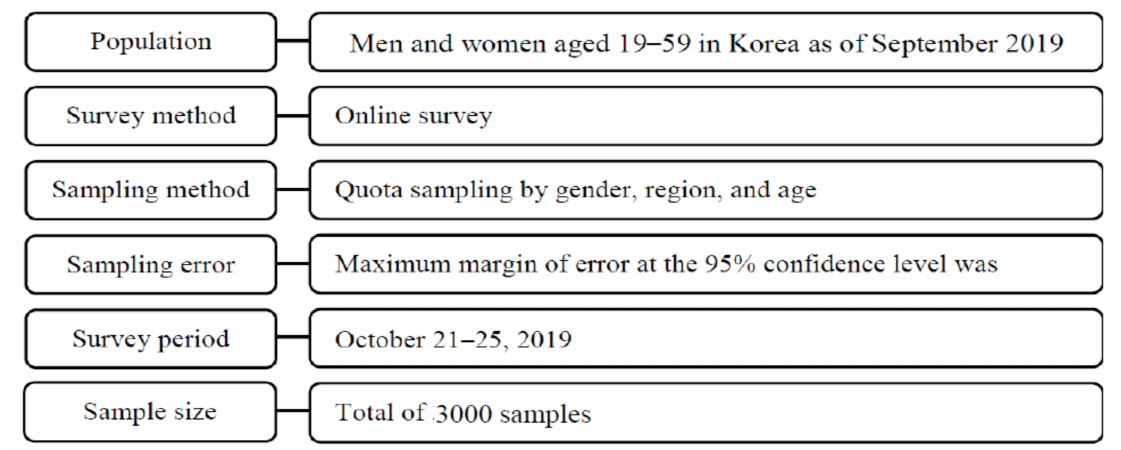
Figure 2. Outline of the survey design.